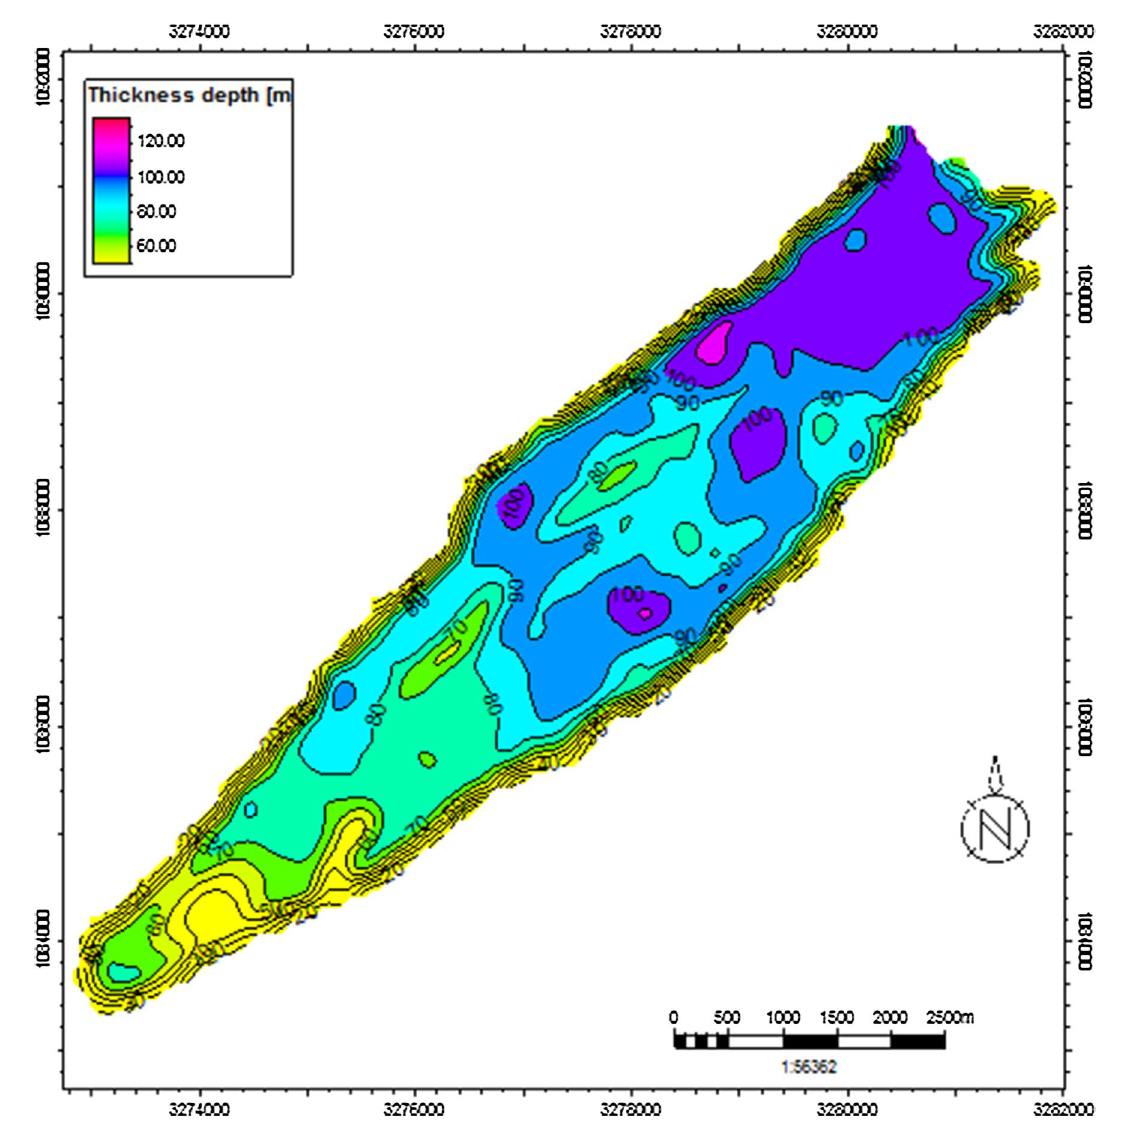
Fig. 4 Reservoir thickness